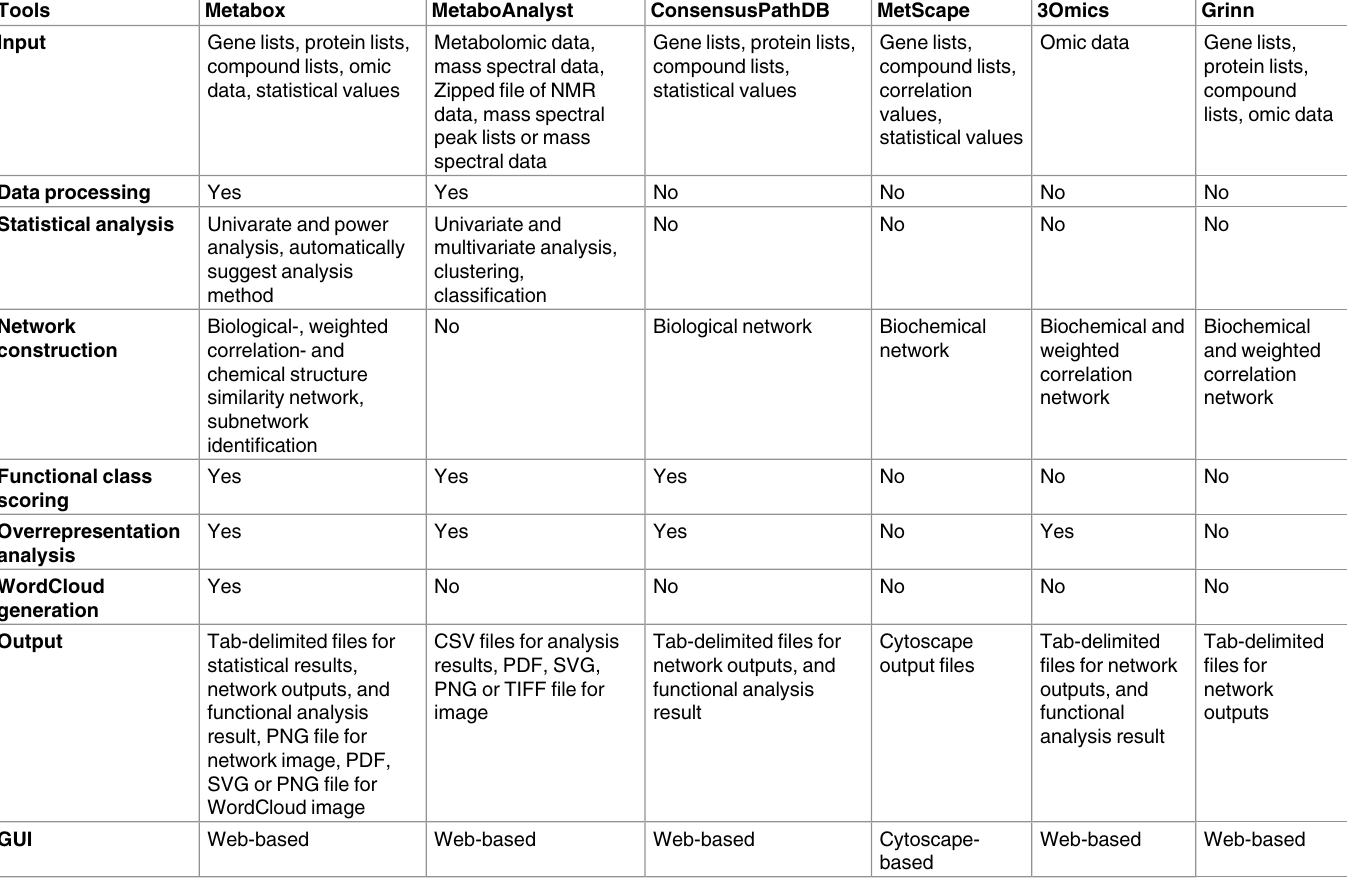
Table 2. Comparison with existing tools for analysis and interpretation of metabolomic